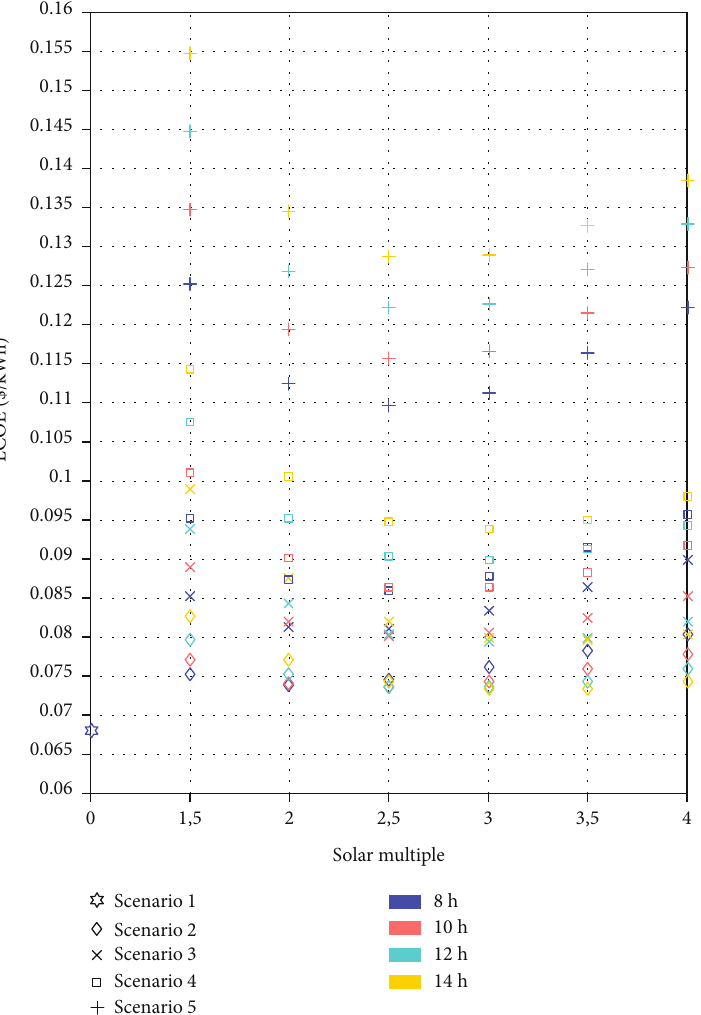
Figure 10: The LCOE from all simulated